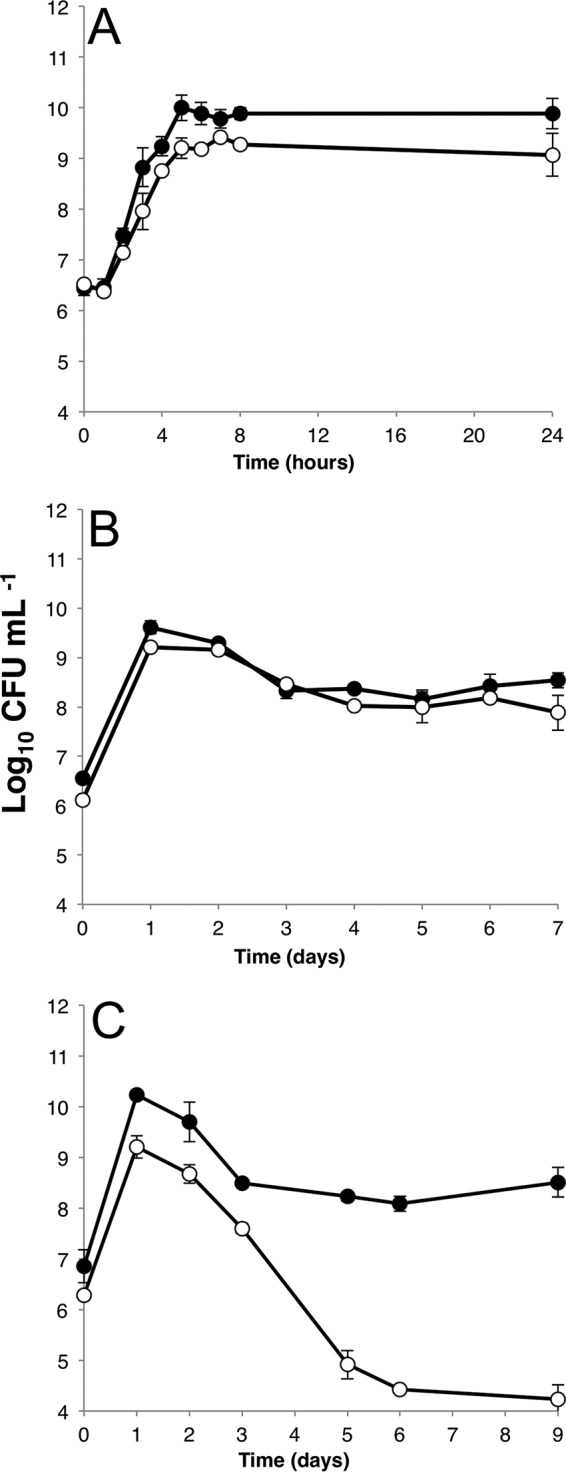
Growth of WT and dam strains in monoculture and competition. (A) Twenty-four hours of growth in LB monoculture of the wild-type strain (black circles) and the dam mutant strain (white circles). (B) Seven days of incubation in LB monoculture of the wild-type strain (black circles) and the dam mutant strain (white circles). (C) Coculture of WT strain (black circles) and dam strain (white circles) in LB. Strains were inoculated at equal densities and competed for 9 days. All experiments are biological replicates done in triplicate; error bars represent the standard deviations.